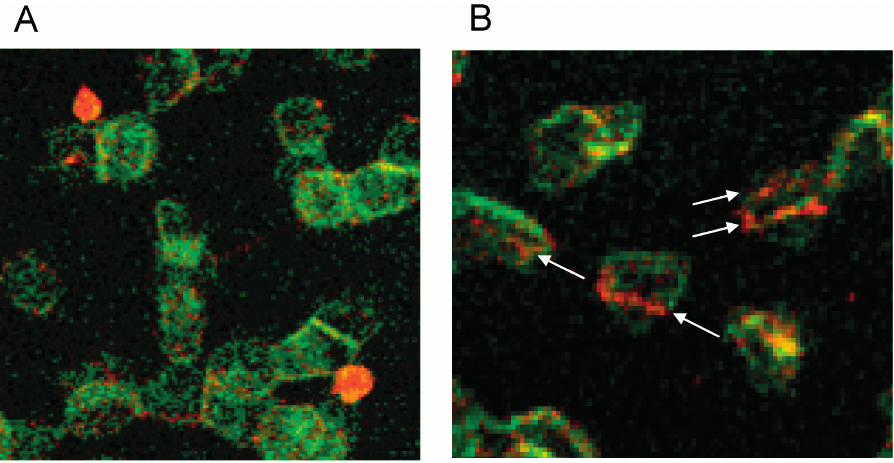
Figure 15. ( A ) Antibody stained Actin protrusions in erythrocytes suspended in a plasma/Iodixanol mixture (30% v / v ) or ( B ) Band 4.9 bands in erythrocytes in a plasma/Iopromide mixture (30% v / v ) (reprinted from reference [23], Copyright 2013, with permission from IOS Press).